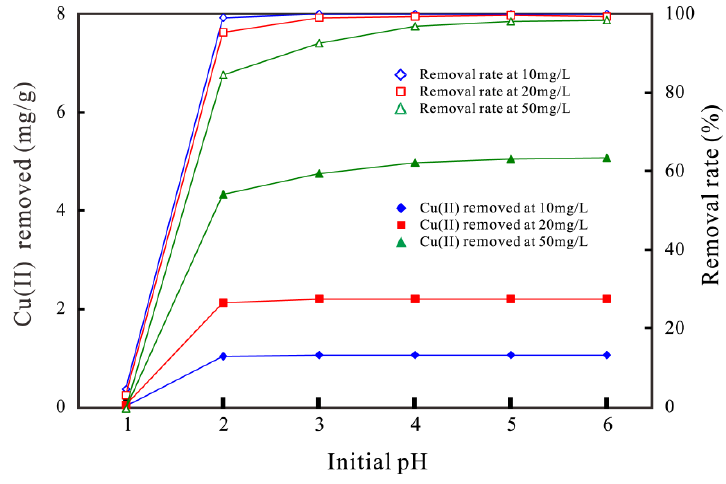
Figure 8. Influence of initial pH on Cu (II) removal by SC–HA/C (25 °C; initial concentration 10~50